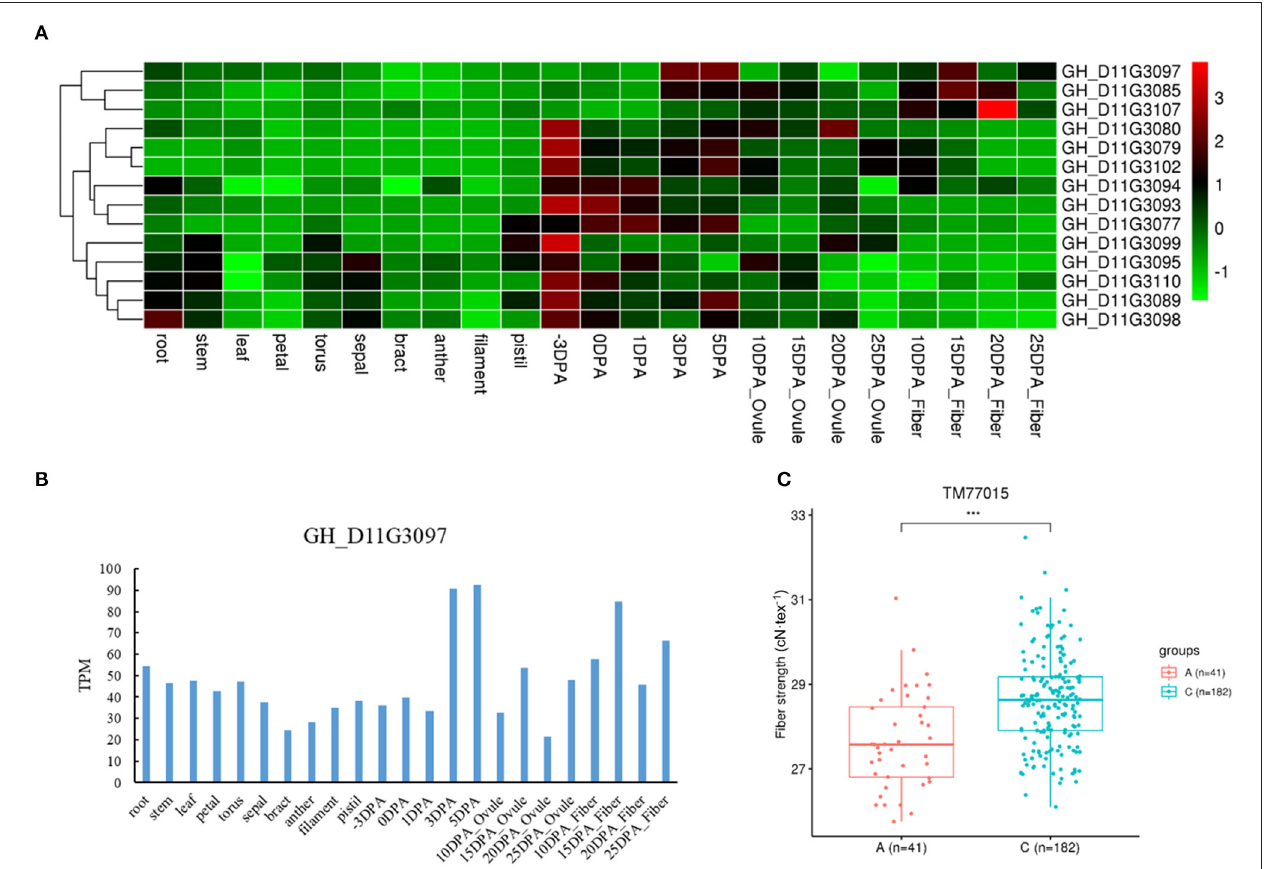
FIGURE 5 | Quantitative trait loci (QTLs) and candidate genes located on qtl64 on chromosome D11. (A) Expression heatmap of candidate genes in the qtl64. (B) The expression patterns of the GH_D11G3097 in different tissues. (C) Boxplots for the phenotypic values of quantitative trait nucleotide (QTN) in exon of the GH_D11G3097 . *** P <